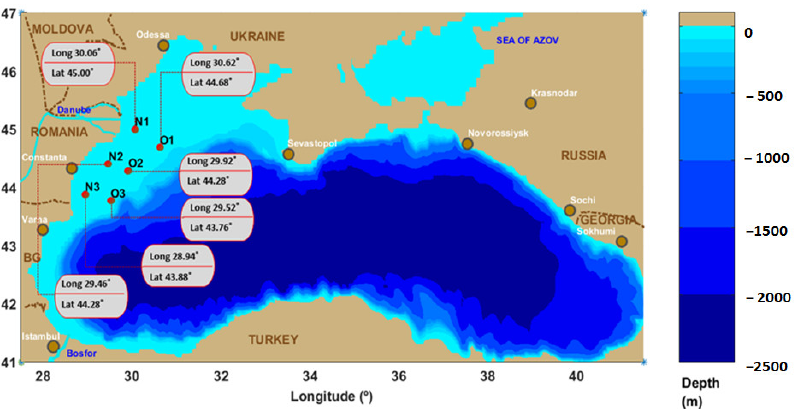
Figure 1. The bathymetric map of the Black Sea and the locations of the six reference sites consid-